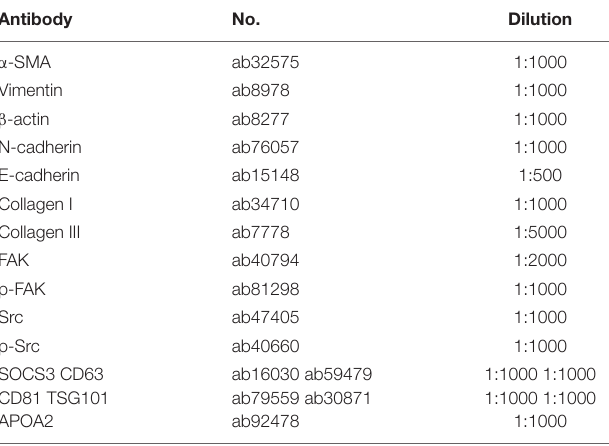
TABLE 2 | Antibodies used in Western blot analysis.